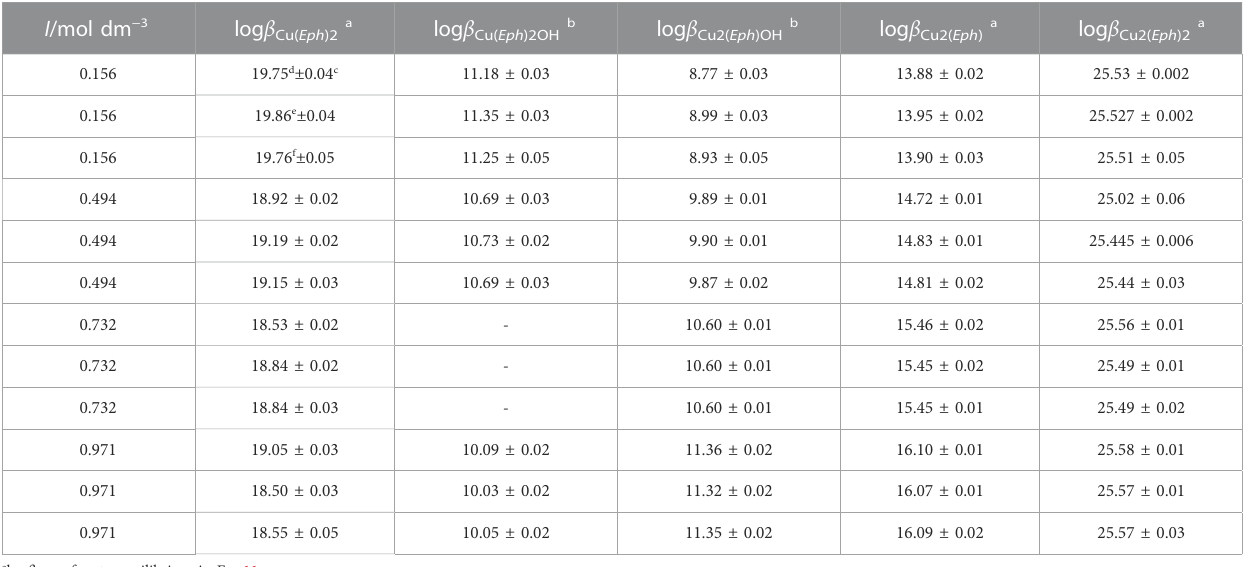
TABLE 3 Experimental and suggested overall formation constants of Cu 2+ / Eph − species at different ionic strengths in NaCl (aq) and T = 298.15K. I /mol dm −